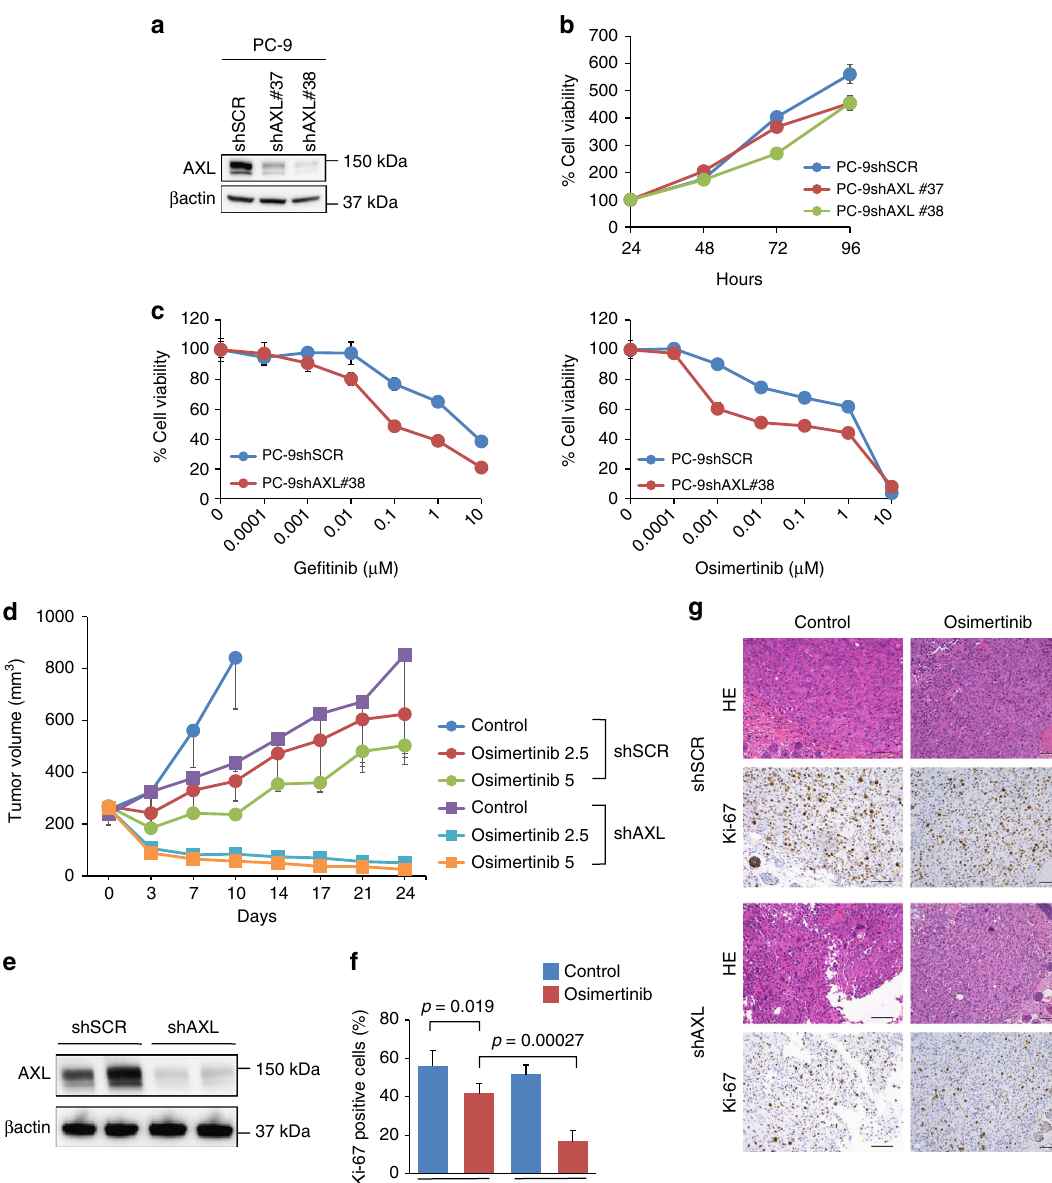
Fig. 6 AXL inhibition shrank PC-9 tumors treated with osimertinib in vivo. Stable PC-9 cell lines were generated by the introduction of short hairpin RNAs (shRNA) that mediated inhibition of AXL expression (#37 and #38) and control nontargeting (SCR) shRNA. a The cells were lysed and the indicated proteins were detected by western blotting. b Cells were incubated for the indicated times and their viability assessed using MTT assays. c Cells were incubated with ge fi tinib or osimertinib at the indicated concentrations for 72 h and the cell viability assessed using MTT assays. d Following the subcutaneous injection of the indicated cells into nude mice, vehicle (control) or osimertinib (2.5 or 5 mg/kg) were administered. Tumor volumes were determined and the results are plotted over time from the start of treatment (mean ± SEM). e Western blotting analysis of the presence of the indicated proteins from the harvested tumors as described for ( d ). f Quanti fi cation of proliferating cells, as determined by their Ki-67-positive proliferation index (percentage of Ki-67-positive cells) as described in the Methods. Columns, mean of fi ve evaluated areas; bars, SD. Comparisons by paired Student ’ s t tests. g Representative images of PC-9 xenografts containing the indicated shRNAs following immunohistochemical staining with antibodies speci fi c for human Ki-67. Bar, 100 μ